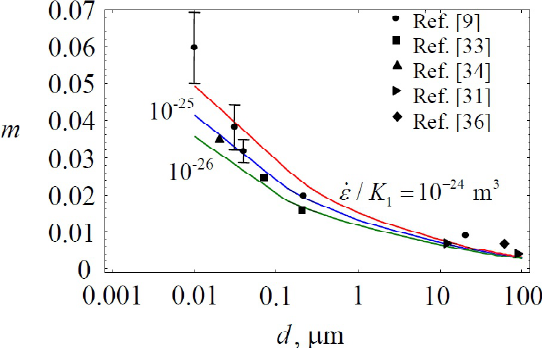
Fig. 3. Strain rate sensitivity m of polycrystalline Cu vs grain size d , for various values of   / K